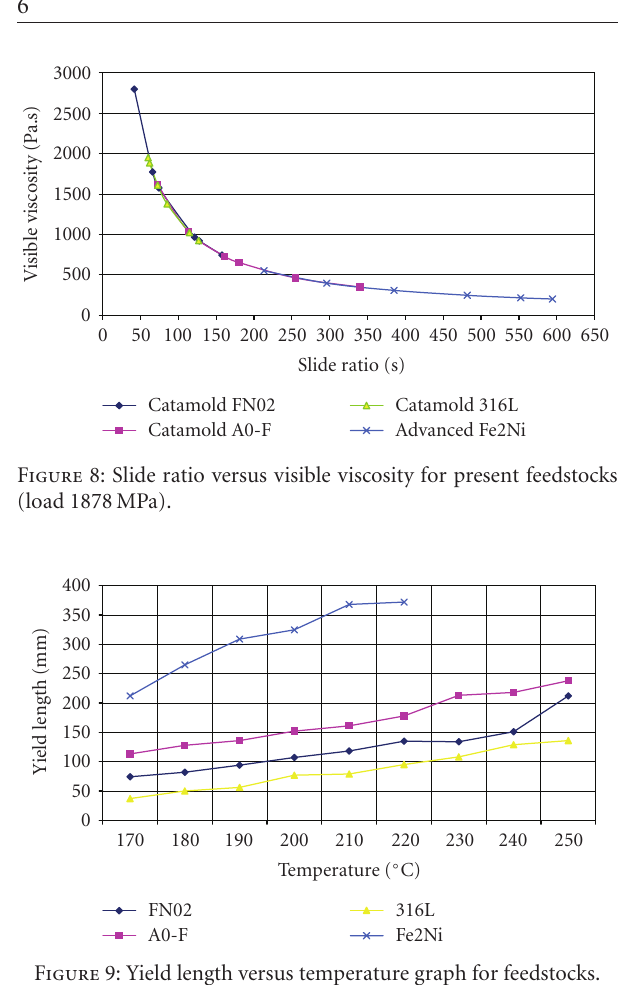
Figure 12: Yield length versus pressure graph for feedstocks pro- duced for PIM by BASF at mould temperature of 140 ◦